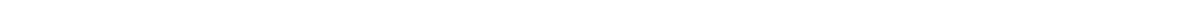
Fig. 1 Screening strategy and phenotypic scoring. a Schematic overview of the screening set up. b Criteria for phenotypic scoring based on morphological (E, H, Y, D, A, T) and segmentation parameters (S, BD, AD, TD, PD, BS). Each are rated from 0 to 3 (normal to strong difference) compared to untreated controls. All parameters together generate a phenotypic vector for each treatment. c Wild type control embryo at 36 hpf, after xirp2a in situ hybridization, illustrating the different scoring parameters evaluated on fi xed embryos at the stage of 36 h post fertilization (hpf). Segmentation parameters (S, BD, AD, TD, PD, BS) evaluated the quality of formed segments at different axial localization (AD, BD, TD) and overall segment boundary quality (BD), shape (BS) or dorsal-ventral segment defects (S) based on xirp2a mRNA expression. The phenotypic vector displayed below the image re fl ects a normally developed embryo. d Numerical parameter score converted into a color scale bar. e Representative phenotypes of positive controls: 50 µ M DAPT shows posterior myotome boundary defects (bracket and inset) without altering embryonic development otherwise; 10 µ M SU5402 affected embryonic development, with a reduction in antero-posterior axis and yolk extension, together with posterior myotome boundary defects (bracket and inset). Associated fi ngerprints for each positive control illustrate low phenotypic variation in different experiments. Scale bar: 200 µ